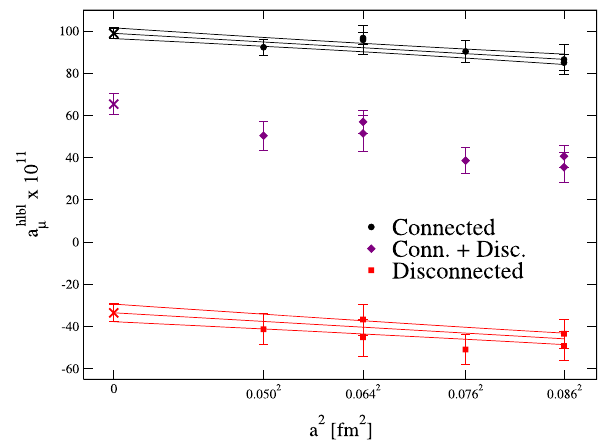
Fig. 14 Combinedcontinuum-extrapolationanalysisfortheconnected and disconnected data. The fits were constrained to have the same slope and the final sum of the two was performed on the constant fit parame- ters.Alsoshownistheindividualsumoftheconnectedanddisconnected pieces. The purple cross represents the addition of the continuum- extrapolated results for the connected and disconnected contributions